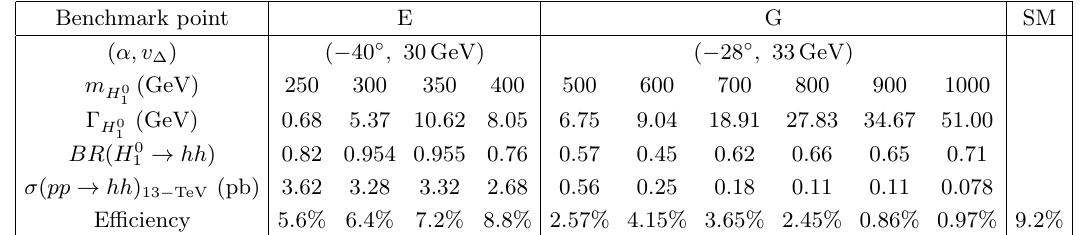
Table 2 . Mass of H 0 , its total decay width, its decay branching ratio and production rate to a pair 1 of SM-like Higgs bosons, and the selection e(cid:14)ciency for benchmark point E in the (cid:13)(cid:13)bb channel, benchmark point G in the 4 b channel, and SM in the bb(cid:13)(cid:13) channel at the 13-TeV